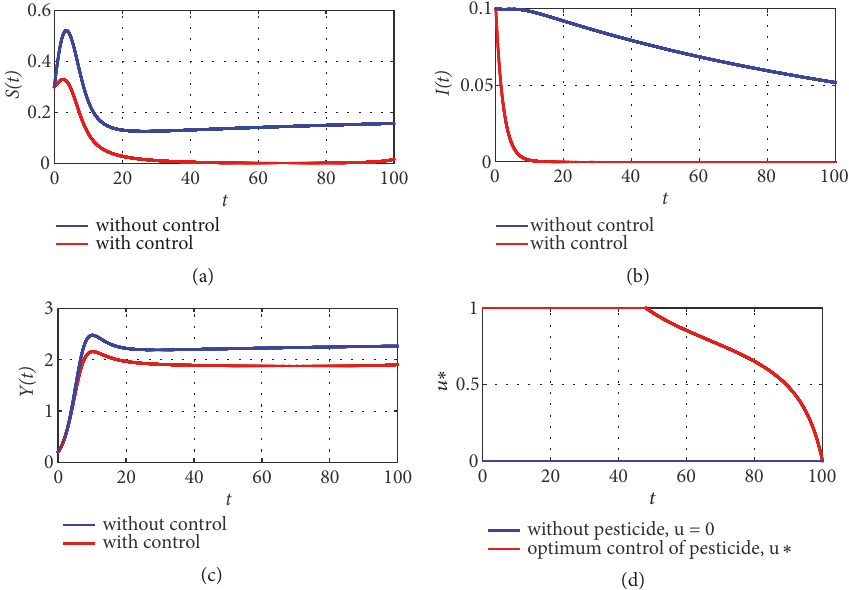
Figure 5: The curves of state variables for system (20a), (20b), and (20c) without and with control: (a) susceptible pest, (b) infected pest, (c) predator, and (d) optimal control